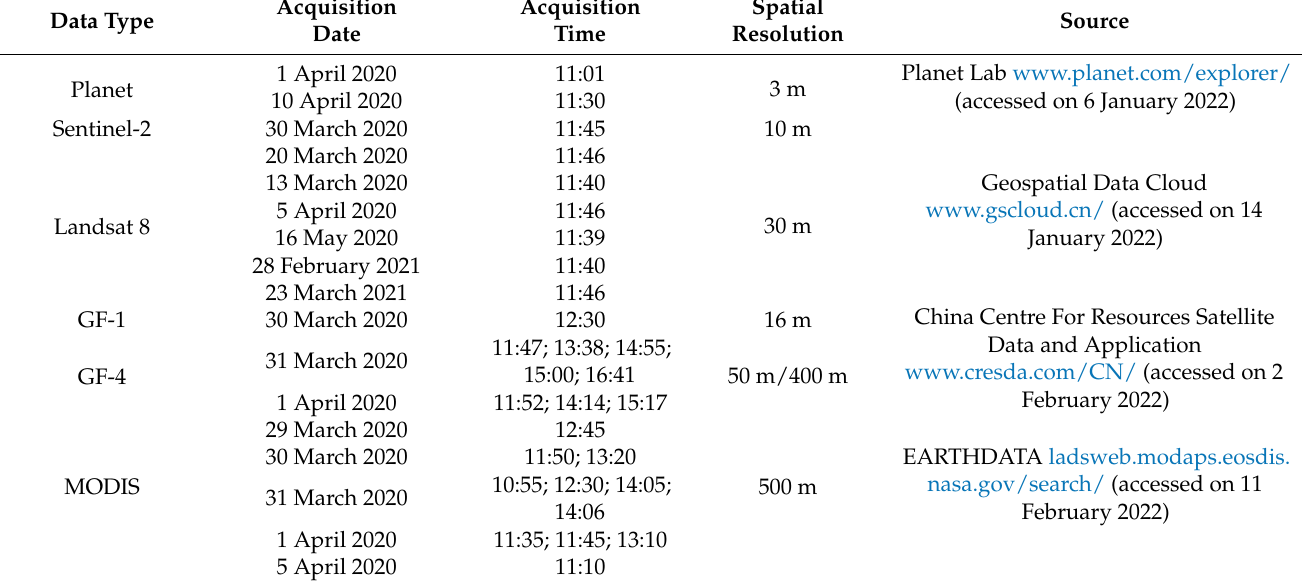
Table 1. Selected remote sensing datasets.